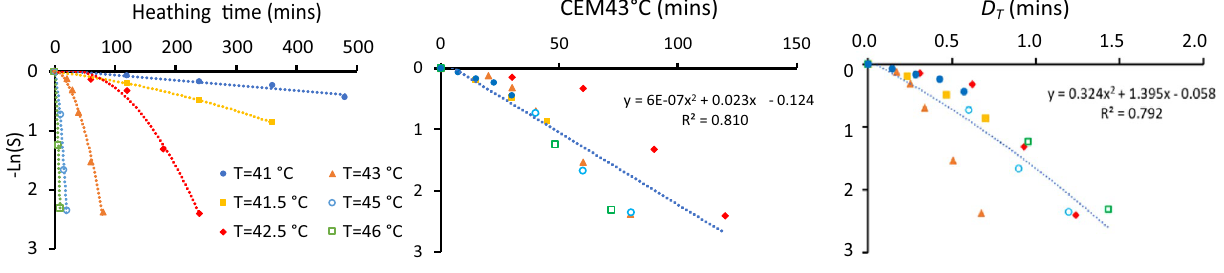
Figure 4. Survival curves of cells after HT treatment. Data extracted from reference 58 ( a ) − ln ( S ) as function of HT treatment time for different temperatures. The lines correspond to quadratic fittings. ( b ) − ln ( S ) as function of the thermal dose as defined in Eq. (20). ( c ) − ln ( S ) as function of the thermal dose as defined in Eq. (21).